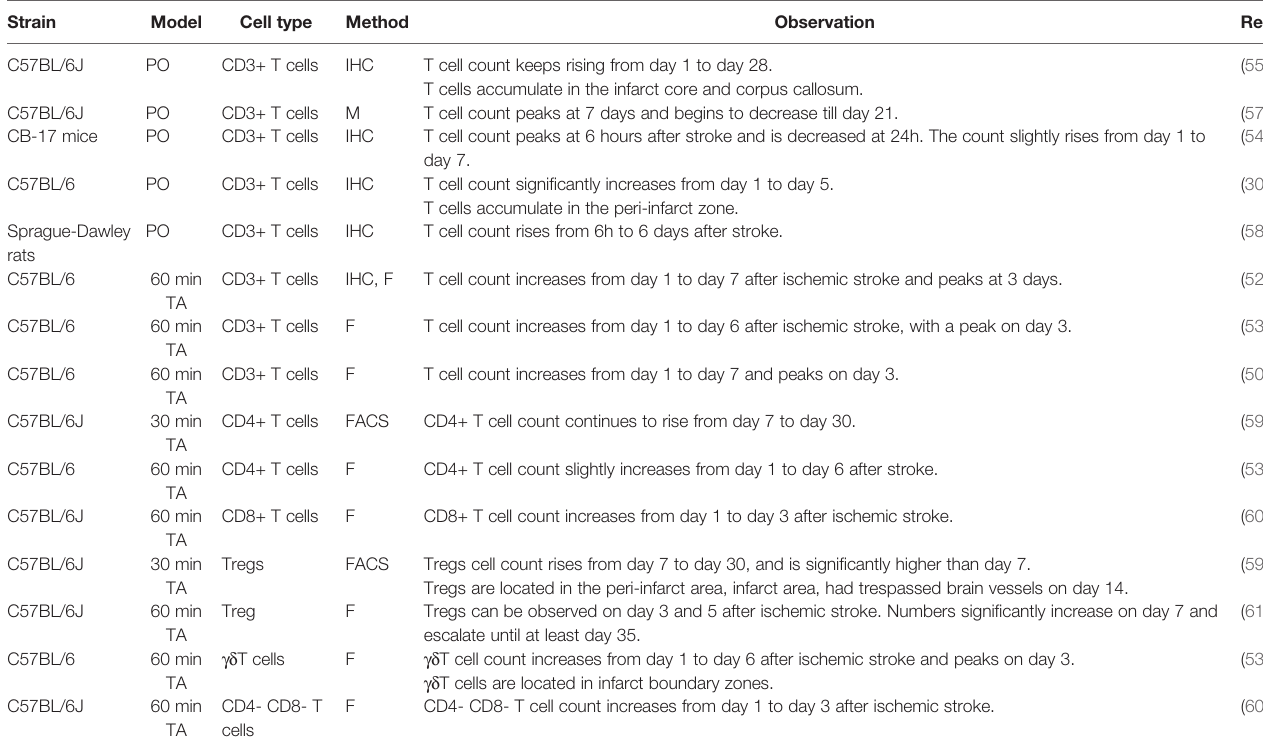
TABLE 2 | Temporal course of T cell in fi ltration to the brain parenchyma Strain Model